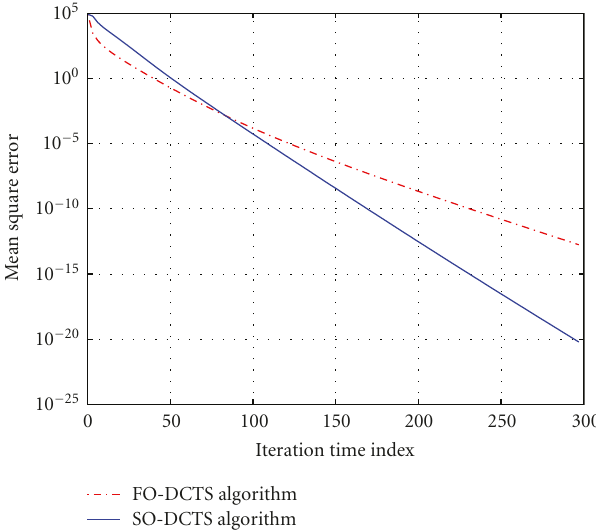
Figure 8: Evolutions of the FO-DCTS and SO-DTS algorithms in random network with 256 nodes when η = 0 . 25 without Gaussian delay between network nodes.